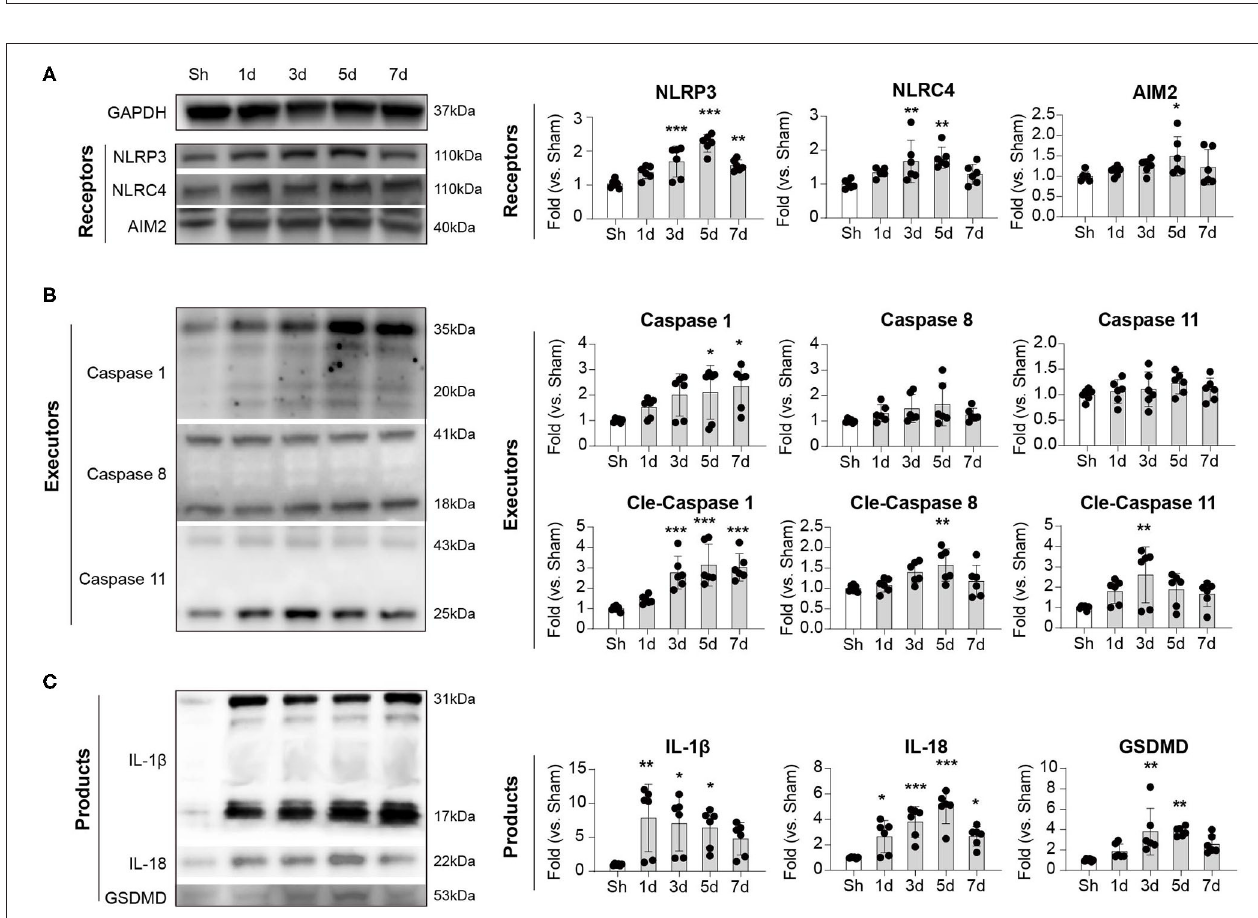
FIGURE 2 | Dynamic alternation of (A) receptors, (B) executors, and (C) products of inflammasome after ischemic stroke. WT C57/Bl6 mice were subjected to Sham or tMCAO operation. Mice were sacrificed at indicated time points and whose brain tissues of the ipsilateral hemisphere were collected. Expression dynamics of inflammasome receptors (NLRP3, NLRC4, and AIM2), executors (Caspase 1, Caspase 8, and Caspase 11), and products (IL-1 β , IL-18, and GSDMD) were analyzed by western blotting. Data were normalized to the expression of GAPDH. N = 4 at each time point. * P < 0.05, ** P < 0.01, *** P < 0.001 vs. Sham (Sh) mice in One-way ANOVA